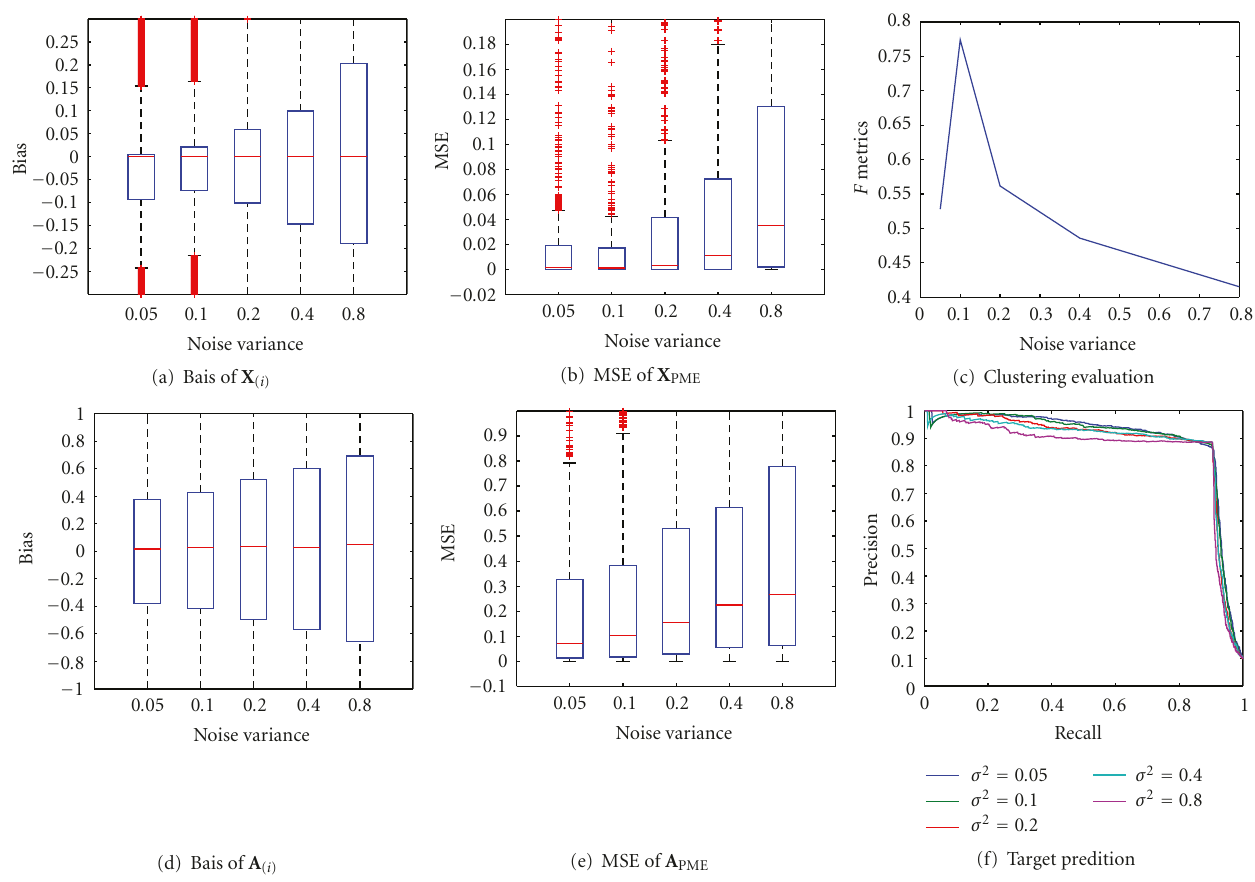
Figure 4: Performance of BSCRFA when noise is di ff